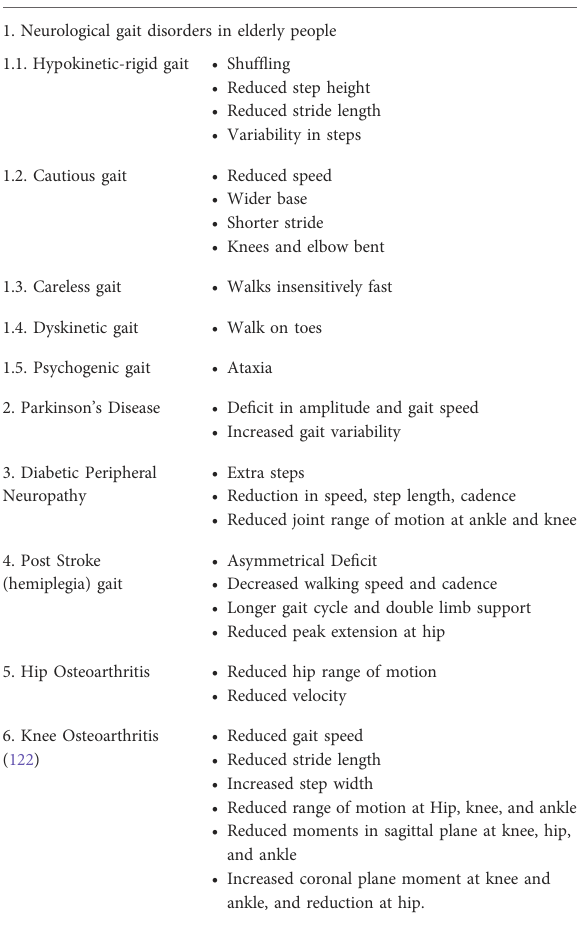
TABLE 2 Effect of pathology on gait